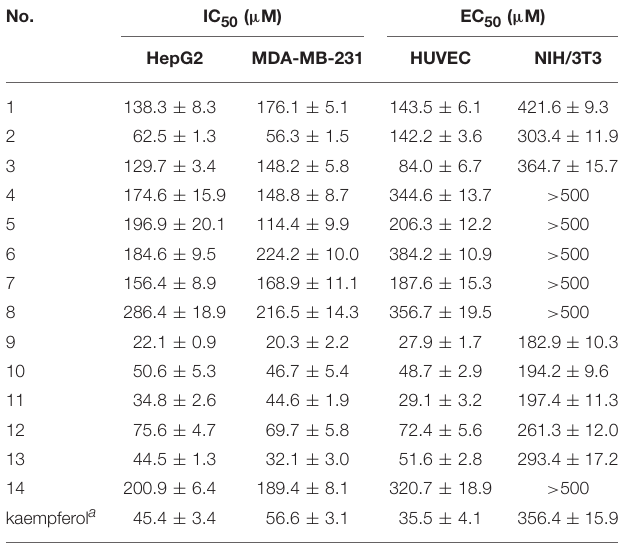
TABLE 2 | Anti-proliferative effect of compounds 1 – 14 on different